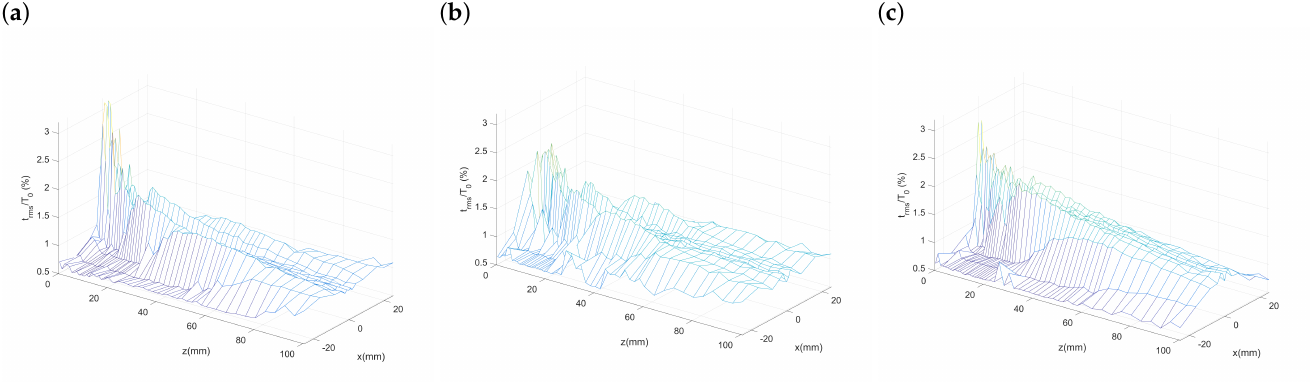
Figure 7. Mesh plots of temperature fluctuation intensity (TFI): ( a ) Original nozzle, ( b ) nozzle with the outer-director, and ( c ) nozzle with the